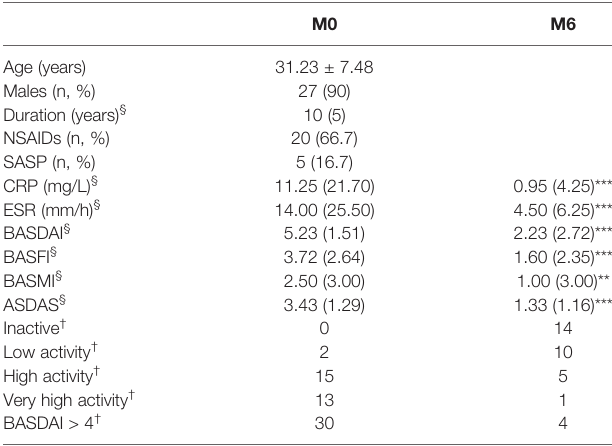
TABLE 1 | Clinical characteristic of AS